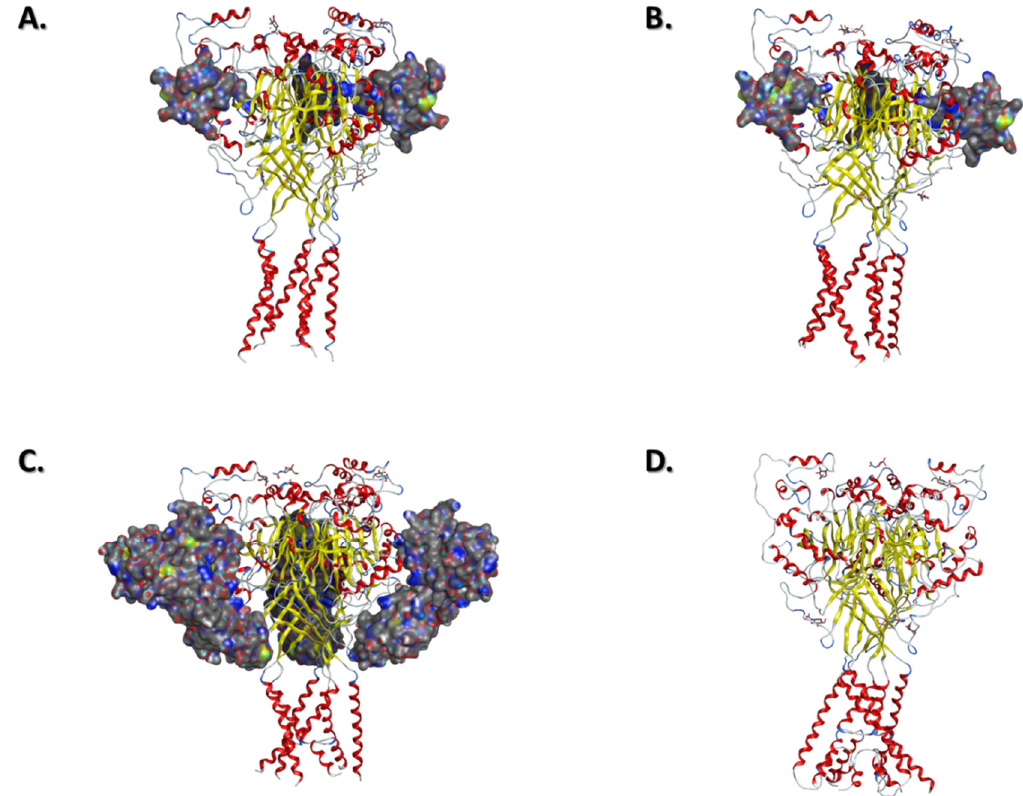
Figure 3. Available ASIC structures with different configuration of the pore . ( A ). Structure of cASIC1a in complex with PcTx1 at low pH (PDB: 4ZF0). ( B ). Structure of cASIC1a in complex with PcTx1 at high pH (PDB: 4ZF1). ( C ). Structure of cASIC1a in complex with MitTx (PDB: 4NTW). ( D ). Structure of cASIC1a with HG loop solubilized by SMA at low pH (PDB: 6VTK).